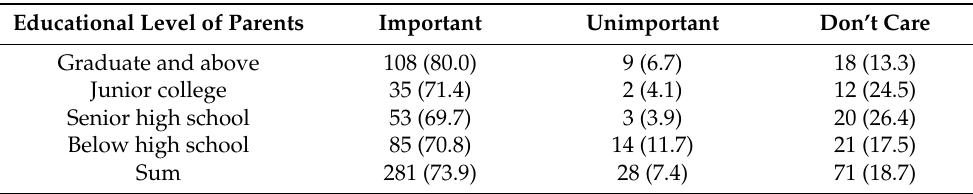
Table 10. The relationship between educational level of parents and the perception of the importance of blood lead ( n (%)).